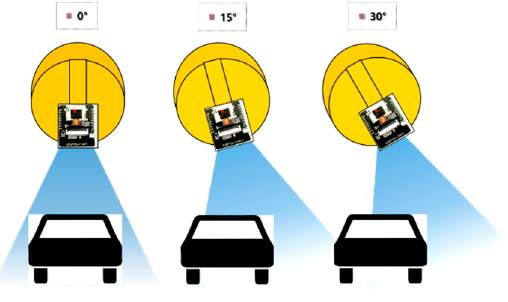
Figure 8. Overview of the experiment to measure the hazard warning accuracy according to the face angle between the camera module and hazardous object.